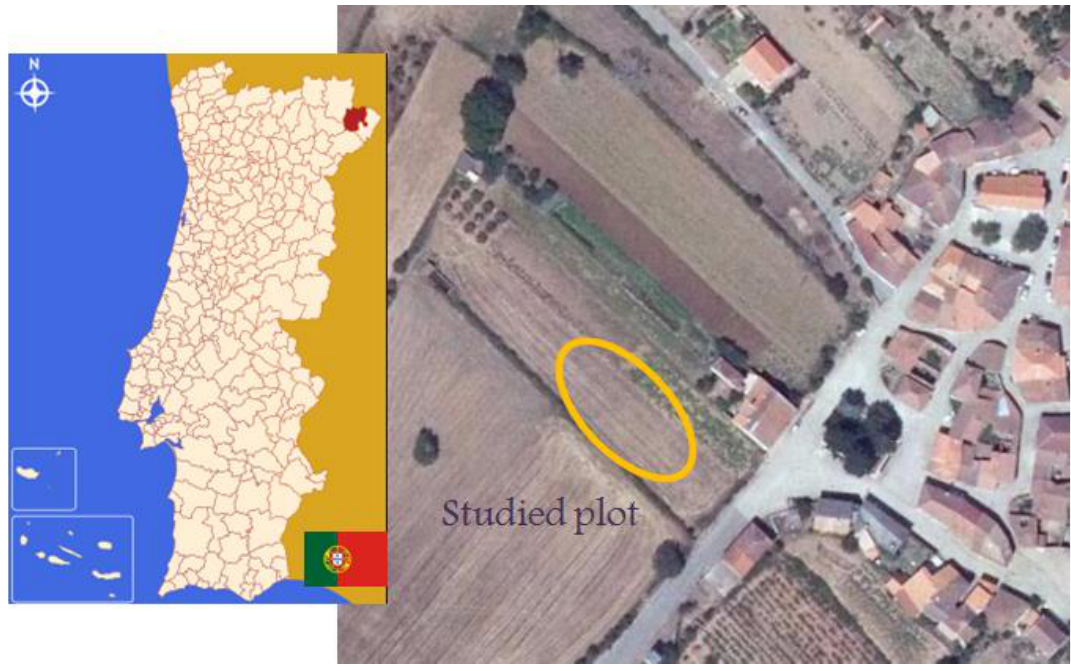
Figure Figure 1: Location of the experimental site: the studied plot in Vale de Frades village, in the Municipality of Vimioso, NE Portugal